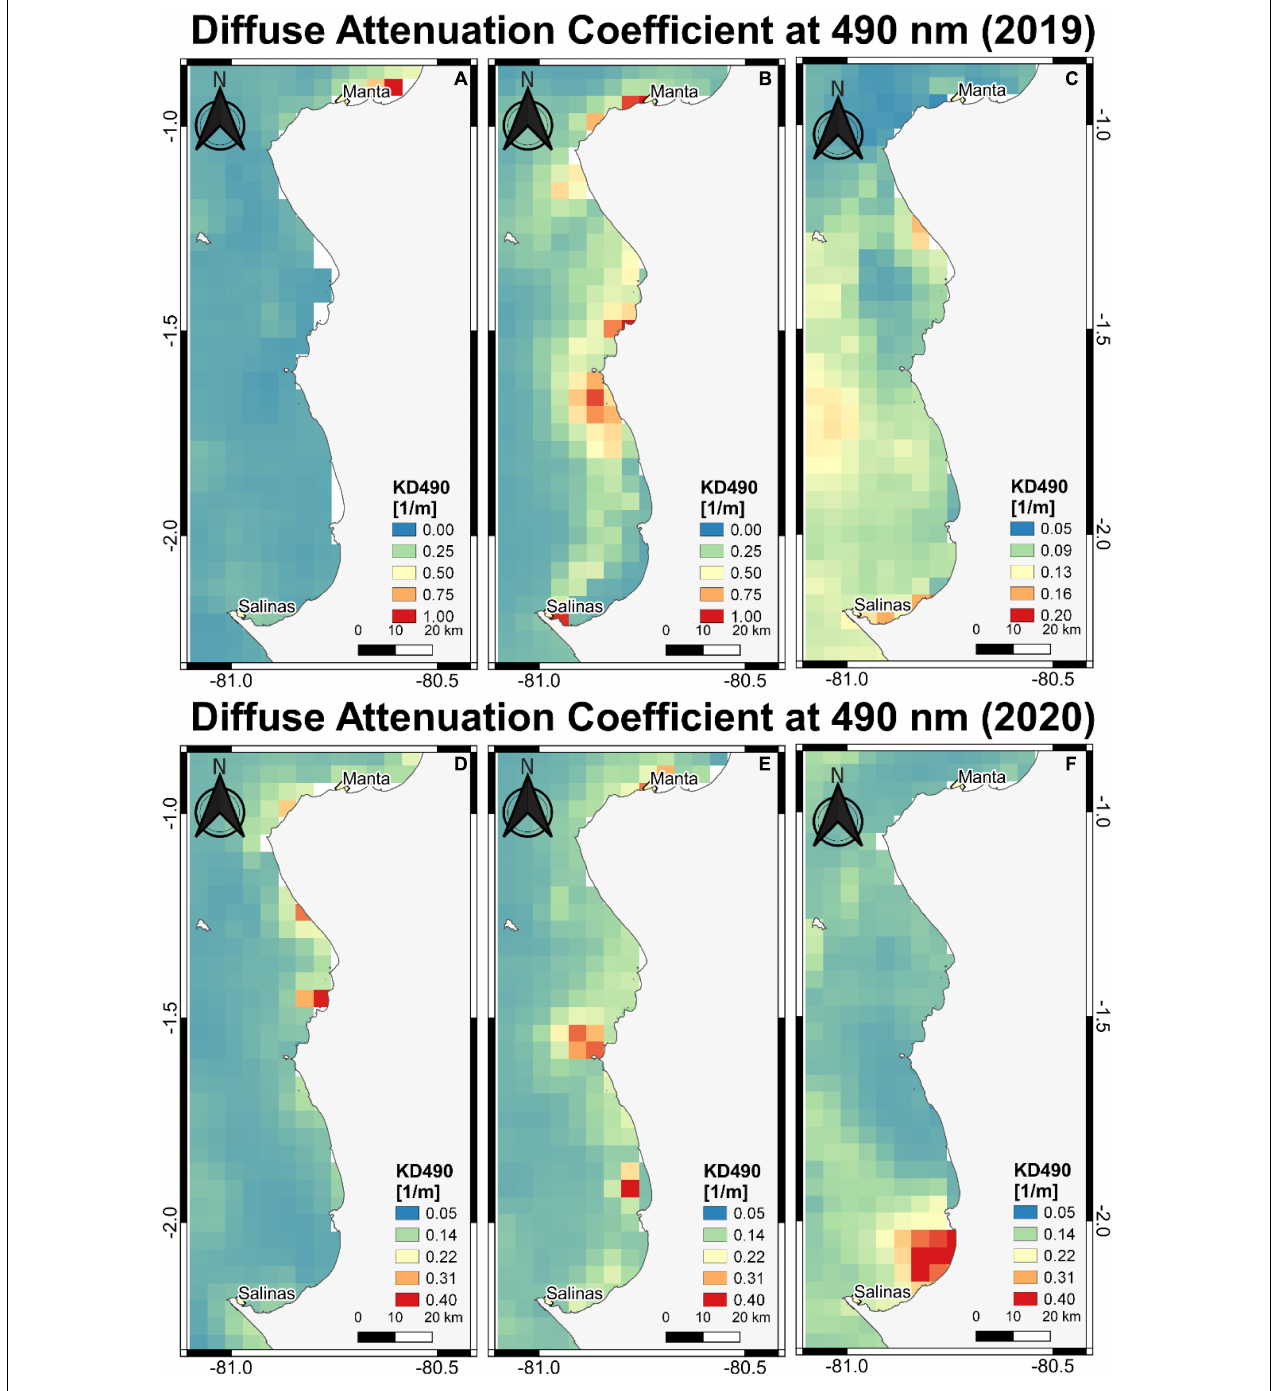
FIGURE 6 | Satellite Atenuation coefficient.